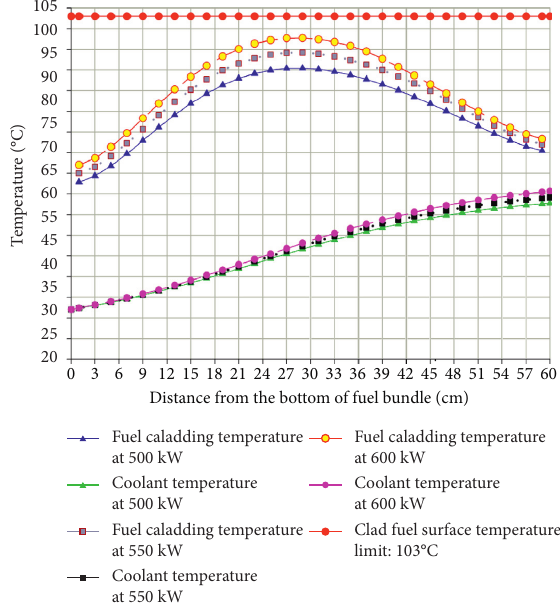
Figure 8: Comparison of the fuel cladding and coolant temper- atures at different reactor power